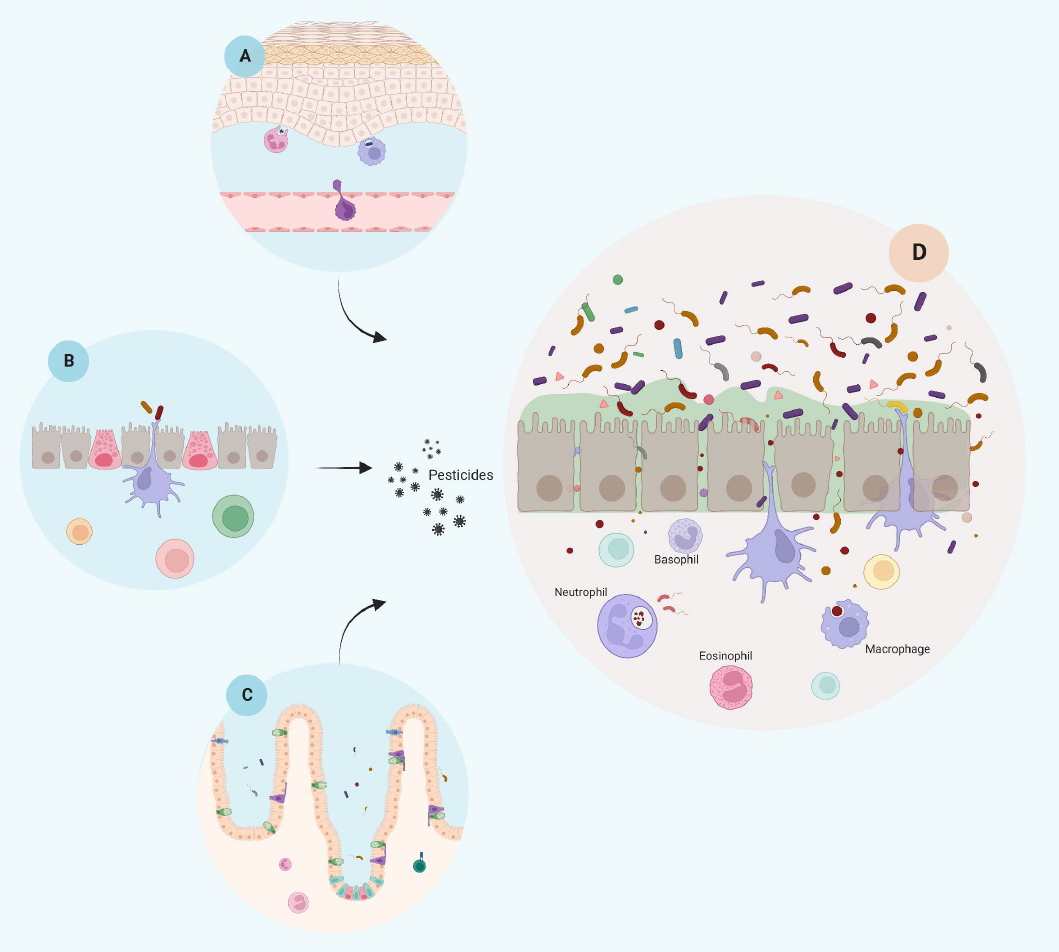
Figure 1. Epithelial barrier integrity is negatively affected by pesticide exposure. On the left, an illustrative representation of the main epithelial barriers in their natural state, i.e., skin ( A ), lung ( B ), and gut ( C ), before exposure to pesticides and potentially other environmental stressors. Following chemical exposure (pesticides), a schematic representation is shown of a generic epithelial tissue presenting several inflammatory response outcomes after disruption of the barrier integrity due to pesticide exposure, such as loss of mucus and villi, increase of barrier permeability by cellular junction rupture, leaking, dysbiosis, and inflammatory response ( D ). Created with BioRender.com.